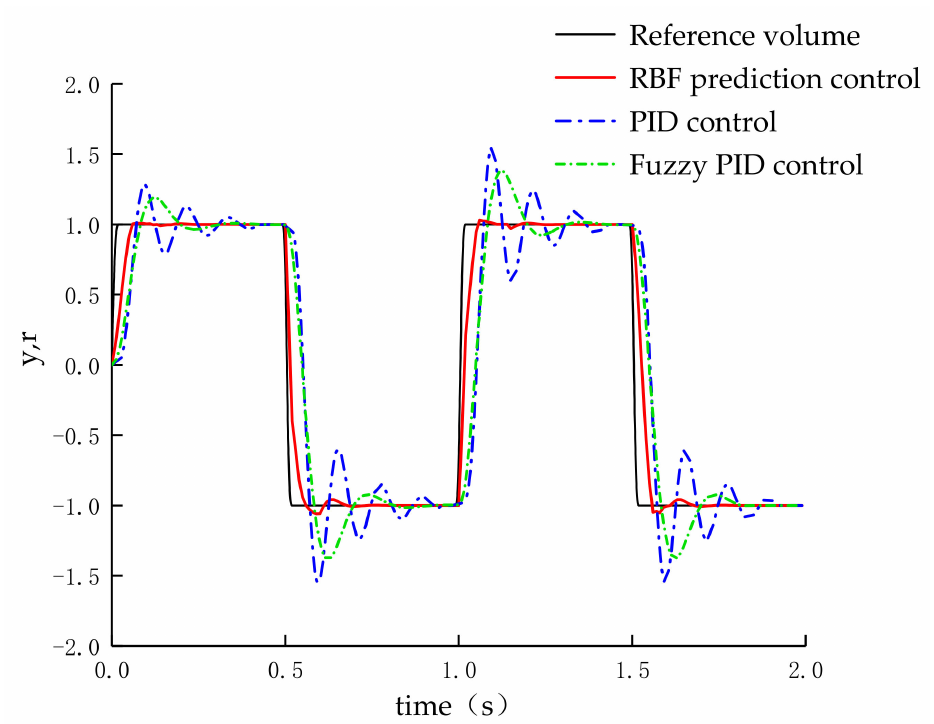
Figure 12. Comparison of control